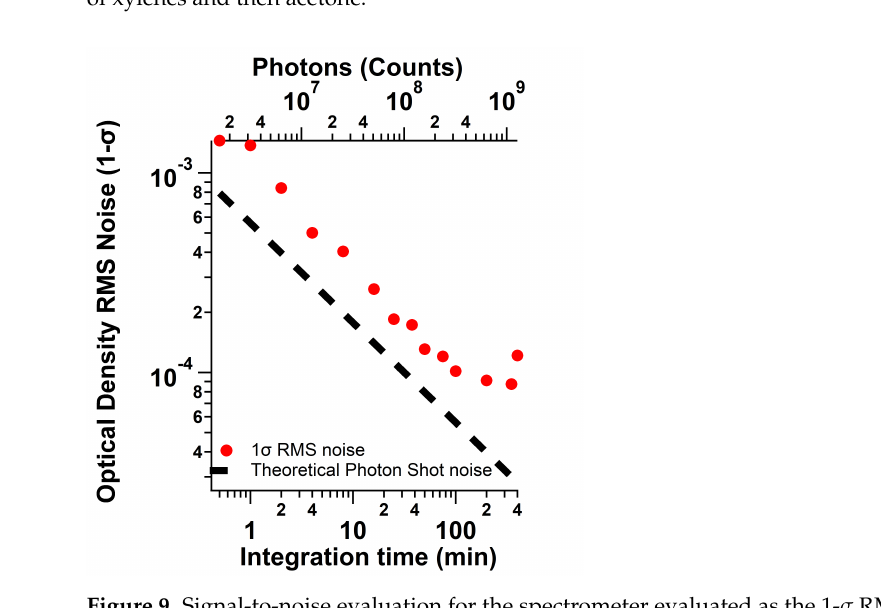
Figure 8. Panel ( A )—fit residual RMS for interference of xylenes and acetone; panel ( B )—fitted polynomial at 308 nm for xylene and acetone interference, showing fitted acetone absorption that is accomodated in the fit by the polynomial; panel ( C )—retrieved concentrations of SO 2 in the presence of xylenes and then acetone.